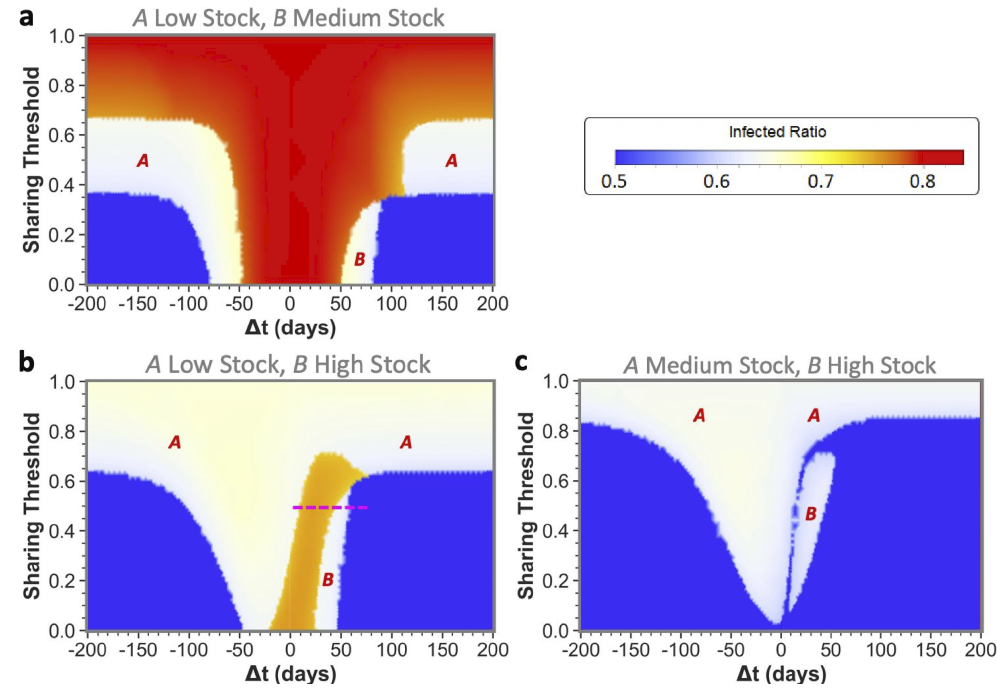
Figure 4. Influence of time difference between epidemic onset and sharing threshold on total infected ratio for unequal maximum stock communities. Respectively showing combinations of ( a ) low- and medium-stock ( b ) low- and high-stock and ( c ) medium- and high-stock communities. The epidemic is introduced in A at t = 0, and in B at t = ∆ t . In the white areas, a red letter indicates which of the two communities reached zero stock. The pink dashed line in ( b ) indicates the settings taken for the time evolutions shown in Figure 5. n = 1.7 × 10 7 , R 0 = 2.3, γ = 1/6, r = 0.4, w = 4, P ( 0 ) = 5 × 10 7 , P max = 4 × P i ( 0 ) , D ( 0 ) = P ( 0 )